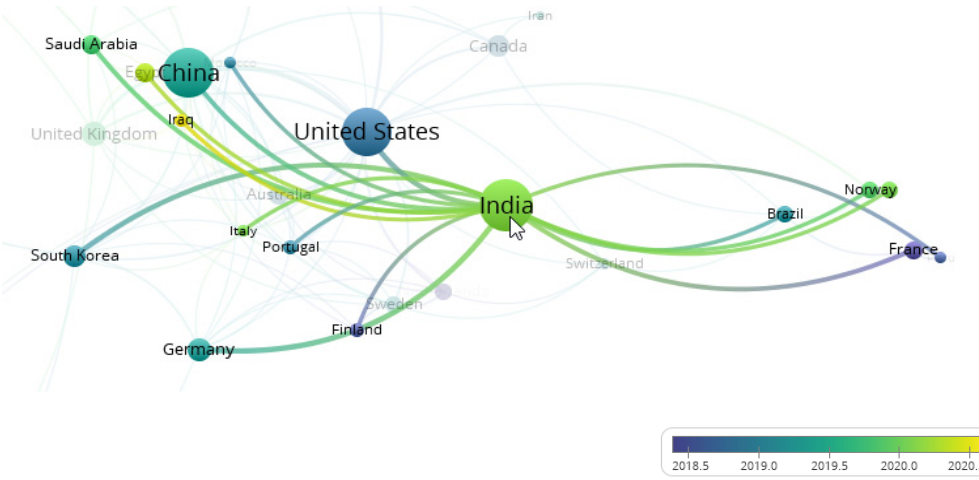
Figure 4. Co-authorship overlay visualization of India.